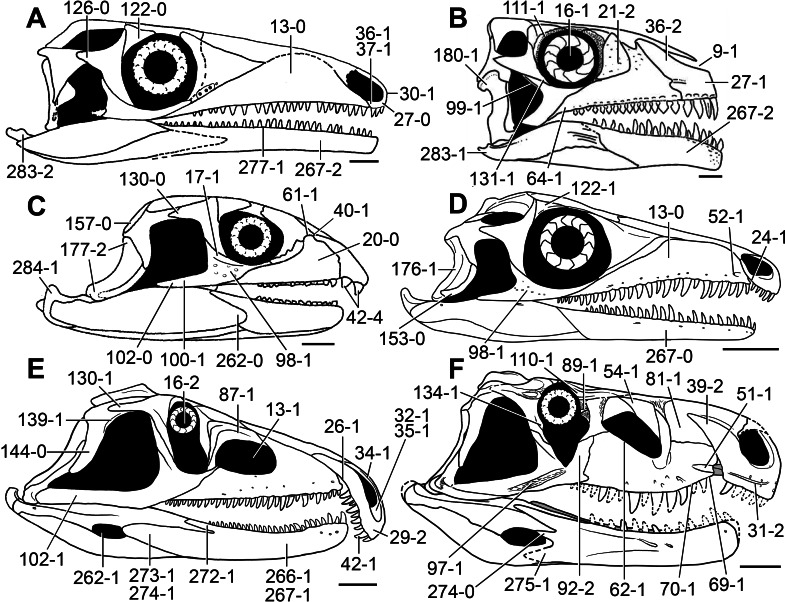
Reconstructions of the skull and lower jaw of Permo-Triassic archosauromorphs in lateral view.(A) Protorosaurus speneri; (B) Azendohsaurus madagaskarensis; (C) Mesosuchus browni; (D) Prolacerta broomi; (E) Proterosuchus fergusi; and (F) Garjainia prima. Numbers indicate character-states scored in the data matrix and anterior direction in towards the right. Scale bars equal 1 cm in (A–D), and 5 cm in (E, F). (A) Modified from Gottmann-Quesada & Sander (2009), (B) modified from Flynn et al. (2010), and (C) modified from Dilkes (1998).